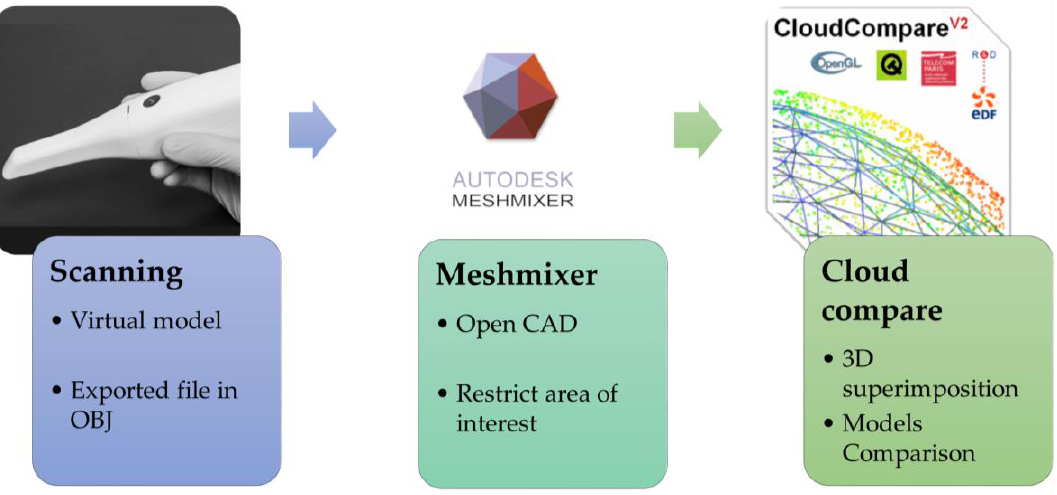
Figure 1. Flowchart summarizing the software sequence and the objective of each step. The exported file also contains the gingival surface, which is a source of error for a deviation in measurement. To overcome this inconvenience, the elimination of the soft tissue was performed before proceeding with the 3D superimposition analysis (Figure 2).